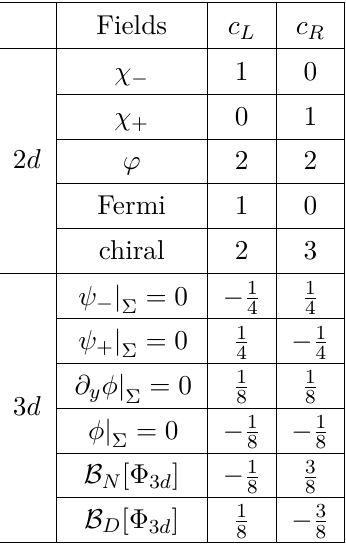
Table 2 . The top entries give the conformal anomalies for 2d Weyl fermions χ ± , complex scalar ϕ and N = (0 , 2) Fermi and chiral multiplets. The bottom entries give the boundary conformal anomalies of 3d Dirac fermion ψ , complex scalar φ with basic boundary conditions and their N = (0 , 2) supersymmetric